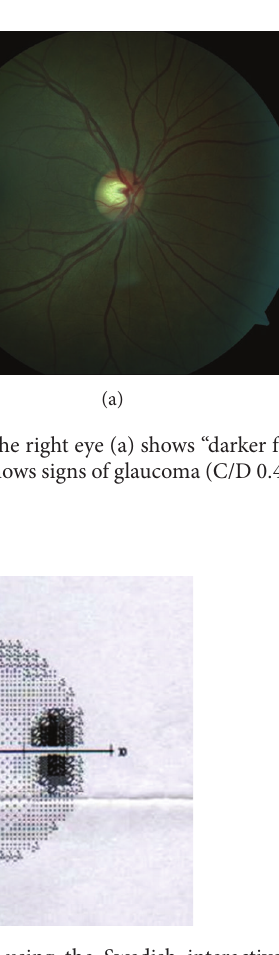
Figure 6: Humphrey visual field using the Swedish interactive thresholding algorithm Standard 24-2 program reveals defects that are typical for glaucoma. The overall sensitivity was reduced in right eye with a mean deviation of 3.97